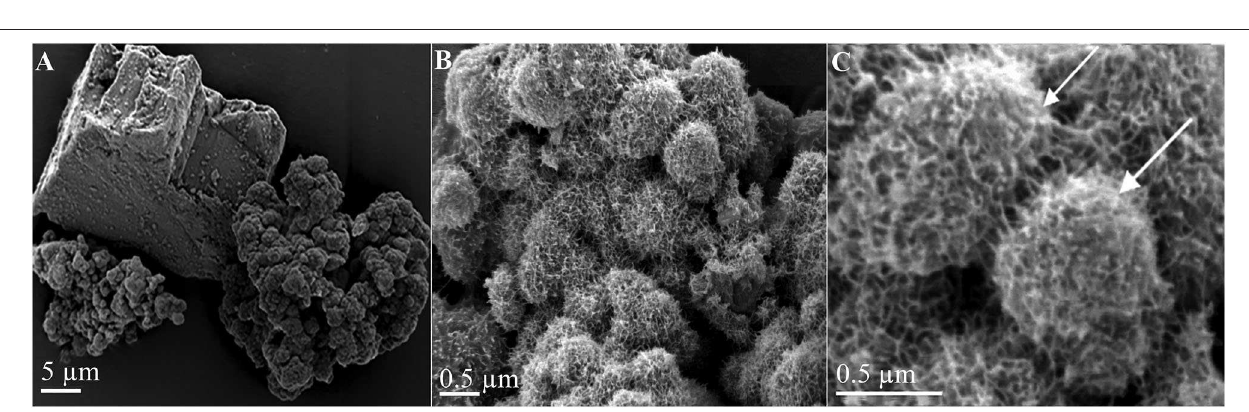
FIGURE 2 | MiL-FISH (multi-labeled fluorescence in situ hybridization) of M. sedula cells supplemented with the stony meteorite NWA 1172 as the sole energy source at cold temperature regime. (A) MiL-FISH image of cells (green) after hybridization with the specific oligonucleotide probe targeting M. sedula. (B) DAPI staining of the same field (blue). (C) Corresponding overlaid epifluorescence image, showing 100% overlap of specific probe with DAPI signals. Cultures of M. sedula were examined with MiL-FISH conducted as described in Kölbl et al. (2017) and Milojevic et al. (2019a) after 2 months of cultivation at the average temperature of 12 ◦ C.